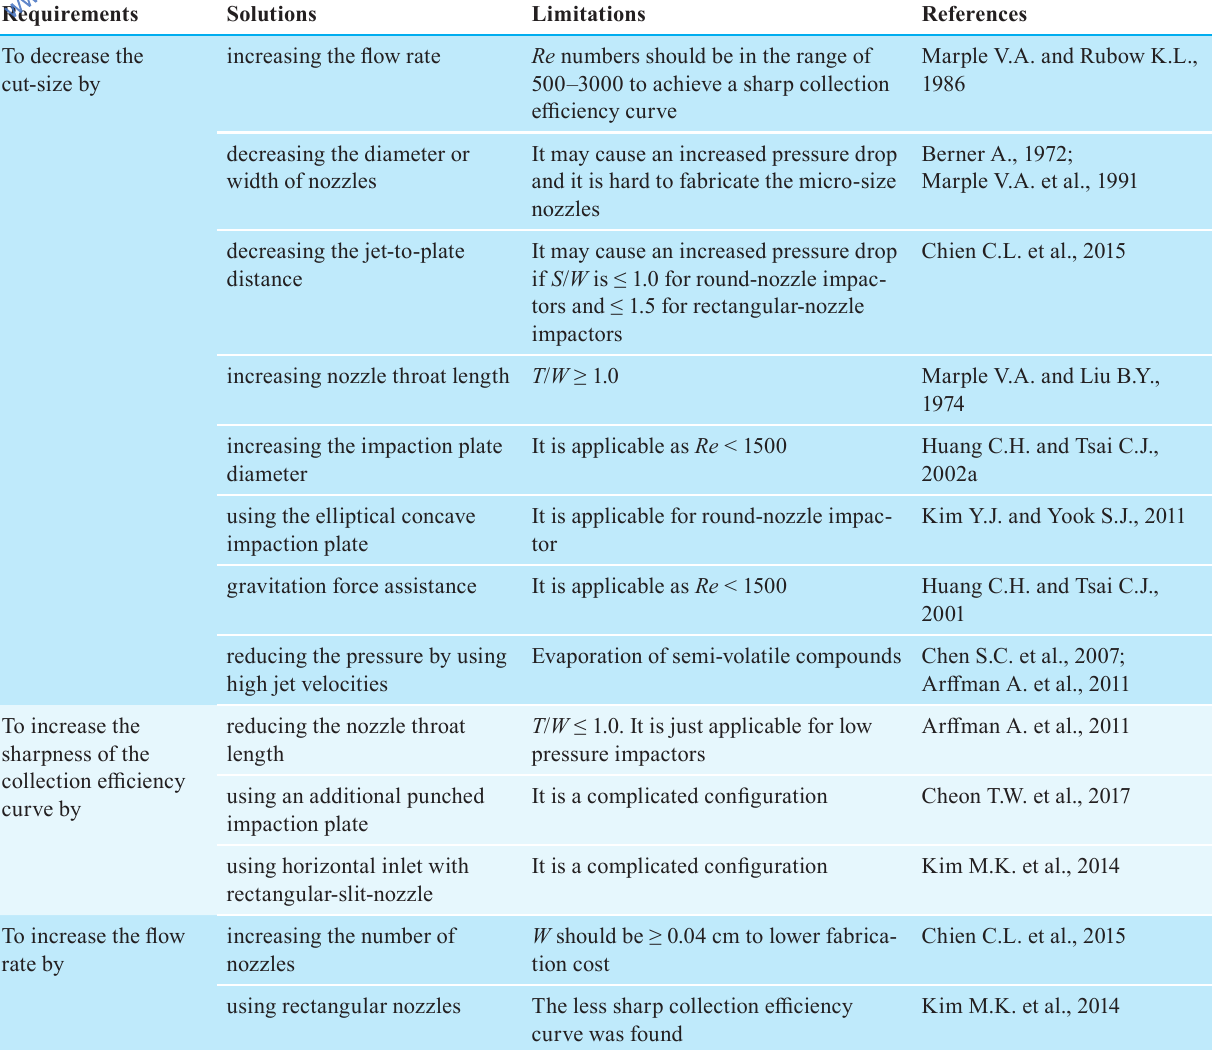
Table 2 Design considerations of inertial